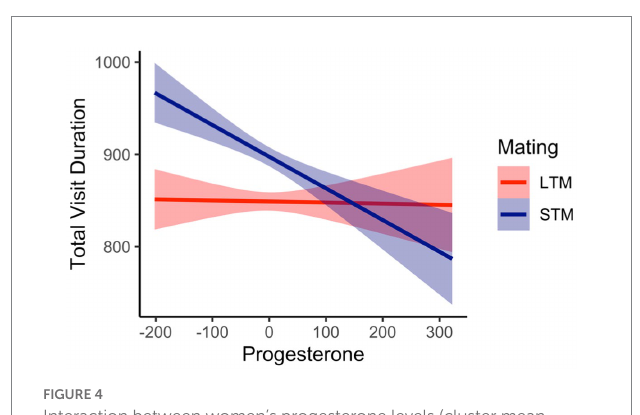
FIGURE 4 Interaction between women’s progesterone levels (cluster mean centered) and mating context predicting total visit duration in milliseconds.